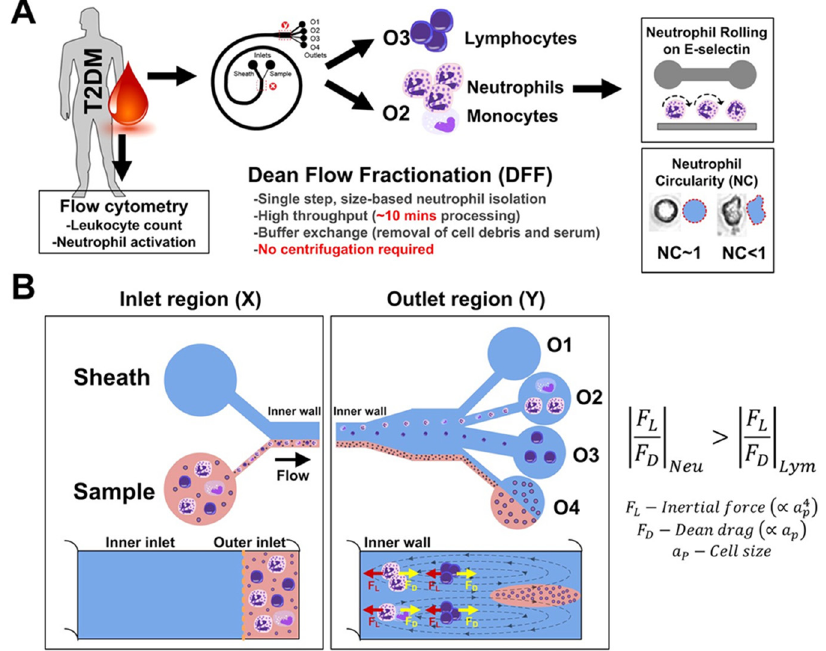
Figure 2. Single step and label-free neutrophil sorting using Dean Flow Fractionation (DFF) microfluidic technology. ( A ) Experimental workflow for neutrophil isolation and phenotyping in type 2 diabetes mellitus (T2DM) patients. Blood samples are lysed and processed using the 2-inlet, 4-outlet spiral microdevice for efficient size-based neutrophil sorting. The purified neutrophils are used for in vitro cell rolling assay in a microchannel functionalized with E-selectin, as well as shape measurement (neutrophil circularity). ( B ) Schematic illustration of DFF separation principle. Under the influence of Dean vortices, small cellular constituents (platelets and lysed red blood cells (RBCs)) and free haemoglobin migrate laterally towards inner wall and back to outer wall due to Dean drag forces (FD (yellow arrows)). Larger leukocytes experience additional strong inertial lift forces (FL (red arrows)) and due to the strong dependence of FL and FD on cell size, larger neutrophils/monocytes (10–12 µm) focus closer to the inner wall and are sorted into outlet 2 while smaller lymphocytes (~7–8 µm) are collected at outlet 3. Outlet 4 is used for removal of platelets, lysed RBCs, and free haemoglobin. Reproduced from [81].